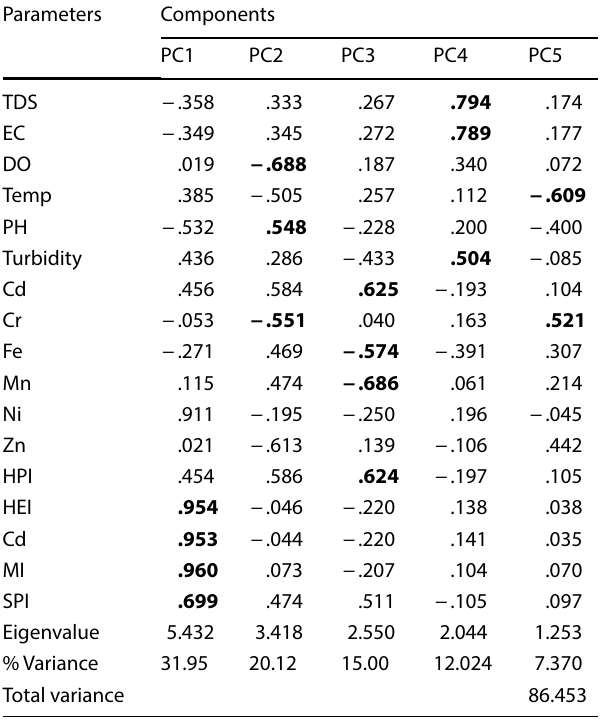
Table 6 Principal components analysis with five extracted compo- nents Parameters